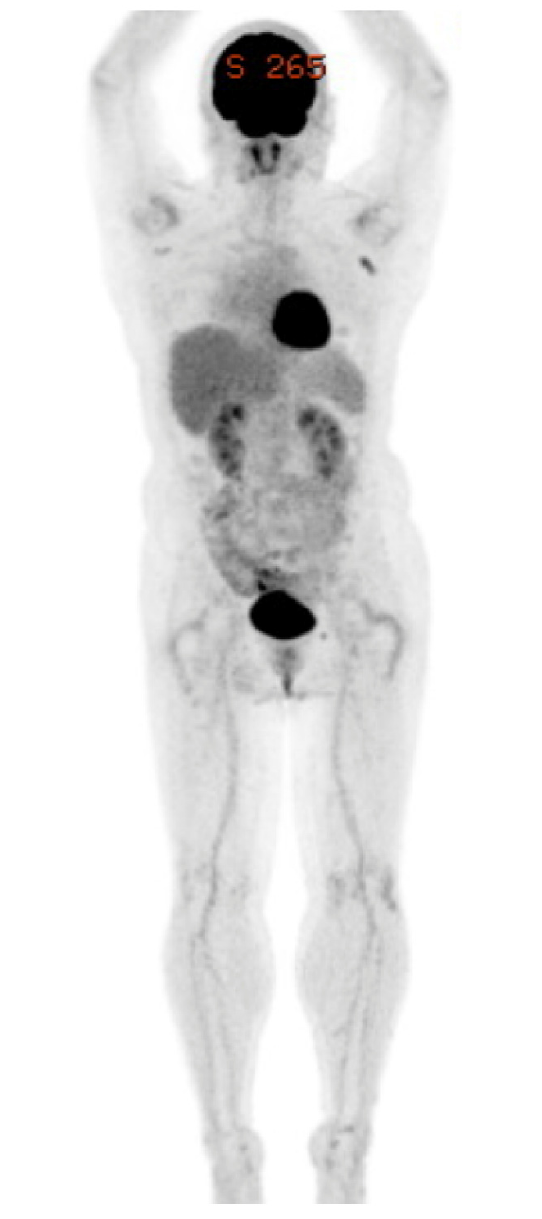
Figure 4. FDG-PET/CT after alectinib therapy. FDG uptake in the multiple lesions was normal. FDG-PET/CT: fluorine-18-2-deoxy-d-glucose positron emission tomography and computed tomography.